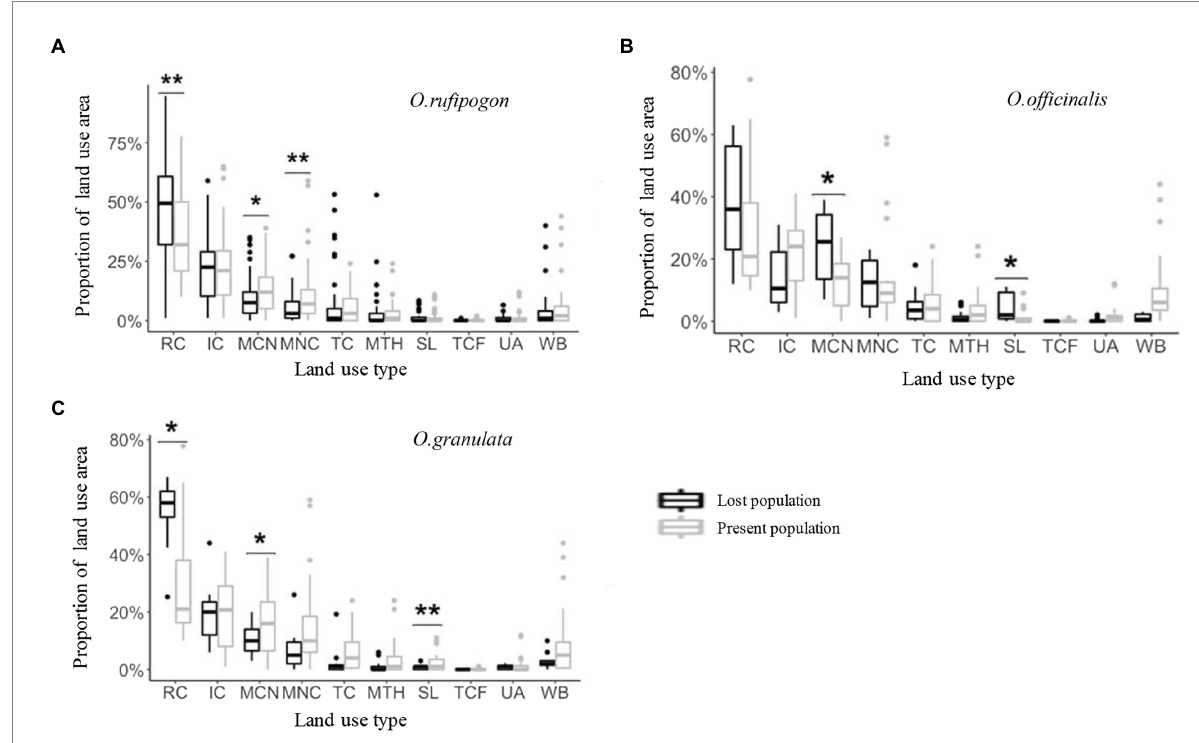
FIGURE 3 The land use area proportion in (A) O. rufipogon (B) O. officinalis (C) O. granulata within a radius of 5 km during 2001~2019. Present population is the population survived during 2001~2019; Lost population presented in 2001 but disappeared in 2019. * p < 0.05, and ** p < 0.01 (Wilcoxon rank sum test). RC, rainfed cropland; IC, irrigated or postflooding cropland; MCN, mosaic cropland, >50% / natural vegetation, <50%; MNC, mosaic natural vegetation, >50% / cropland, <50%; TC, tree cover; MTH, mosaic tree and shrub, >50% / herbaceous cover, <50%; SL, shrubland; TCF, tree cover, flooded, fresh, or brackish water; UA, urban areas; WB, water bodies.